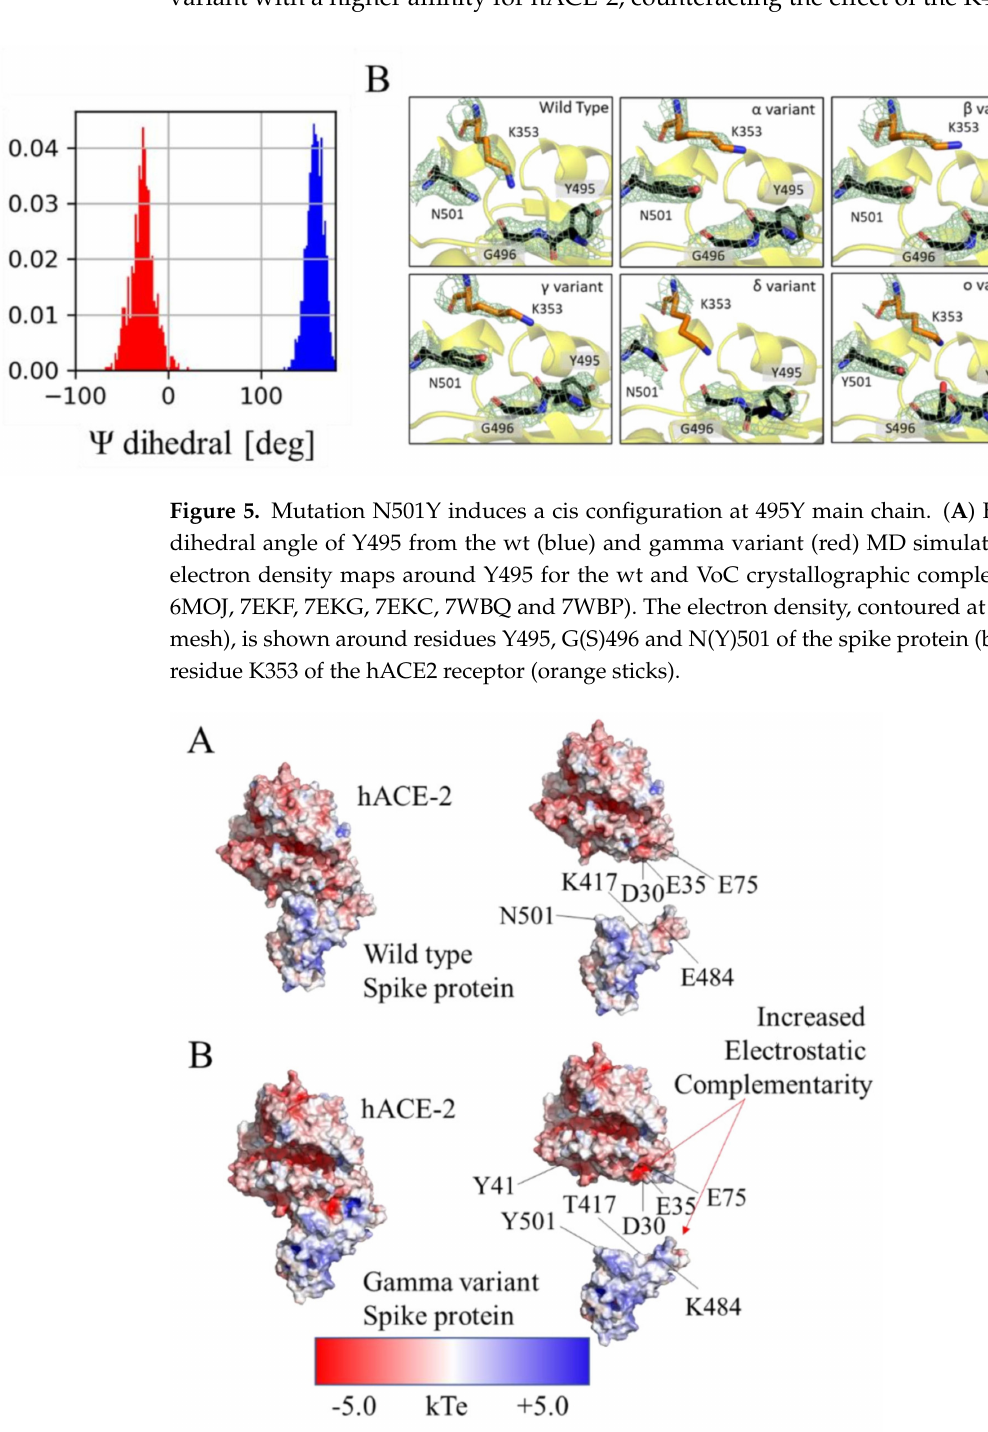
Figure 6. Structural highlights of the E484K mutation. APBS electrostatics analysis for both complexes: ( A ) wild type, and ( B ) gamma variant. Electrostatic complementarity due to the 484K mutation with residues E35 and E75 of hACE-2 are